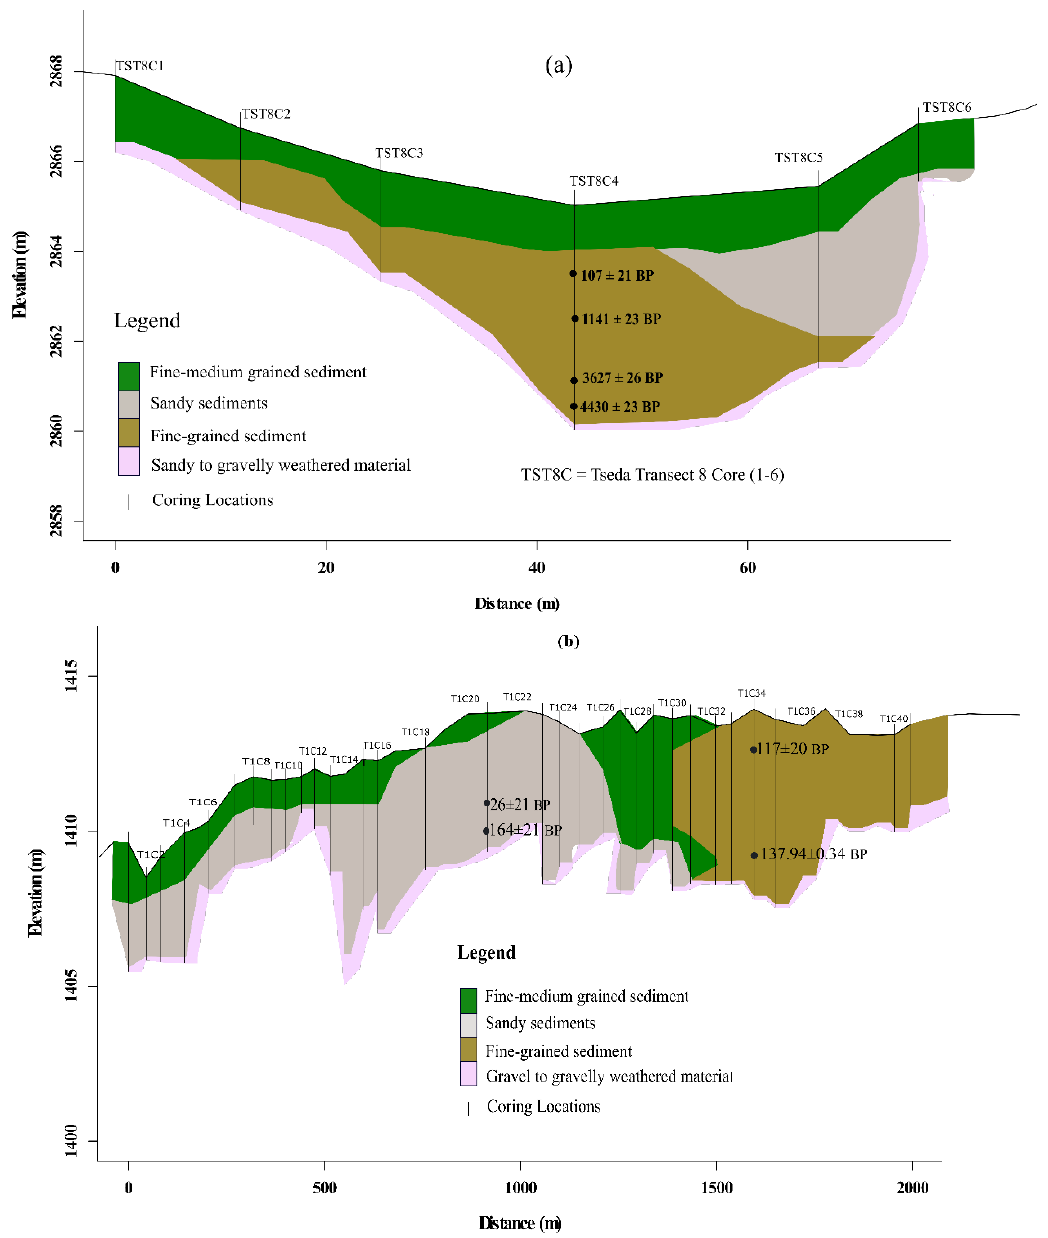
Figure 4. Example a typical cross-section with indication of the various sedimentary units in the ( a ) Chencha and ( b ) Dembelle catchment. Radiocarbon ages are reported in non-calibrated years BP. Table 1. Overview of the floodplain area and sediment deposition within different